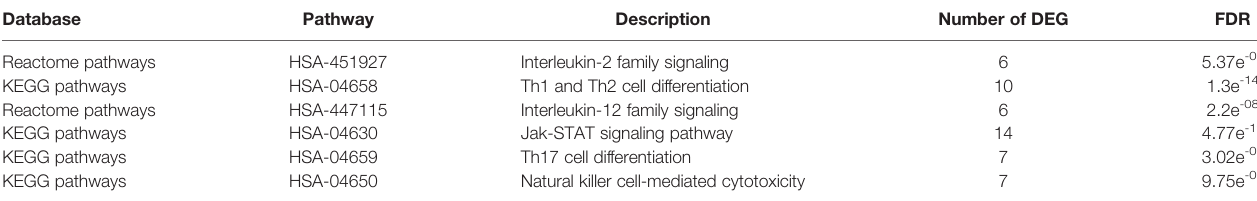
TABLE 3 | Main biological pathways involved in the STRING protein network of differential expressed genes (DEG) between IND and HD